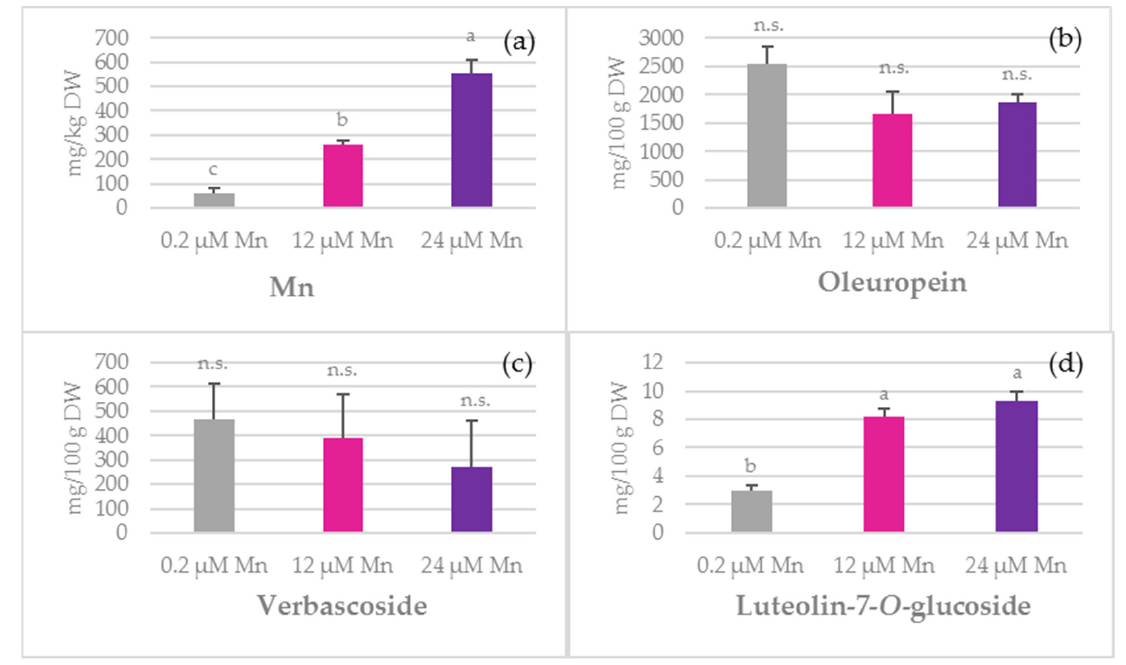
Figure 3. The effect of manganese (Mn) application on: ( a ) Mn, ( b ) oleuropein, ( c ) verbascoside, and ( d ) luteolin-7- O -glucoside concentrations in olive roots of ‘Istarska bjelica’ olive cv. (mean values ± SE, n = 4). Mean values followed by different letters are significantly different at p < 0.05 according to Tukey’s test. DW—dry weight.